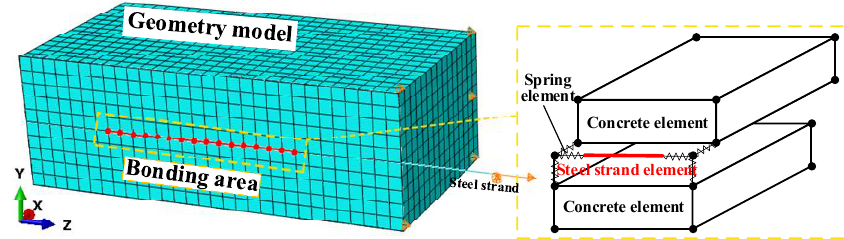
Figure 9. Typical finite element